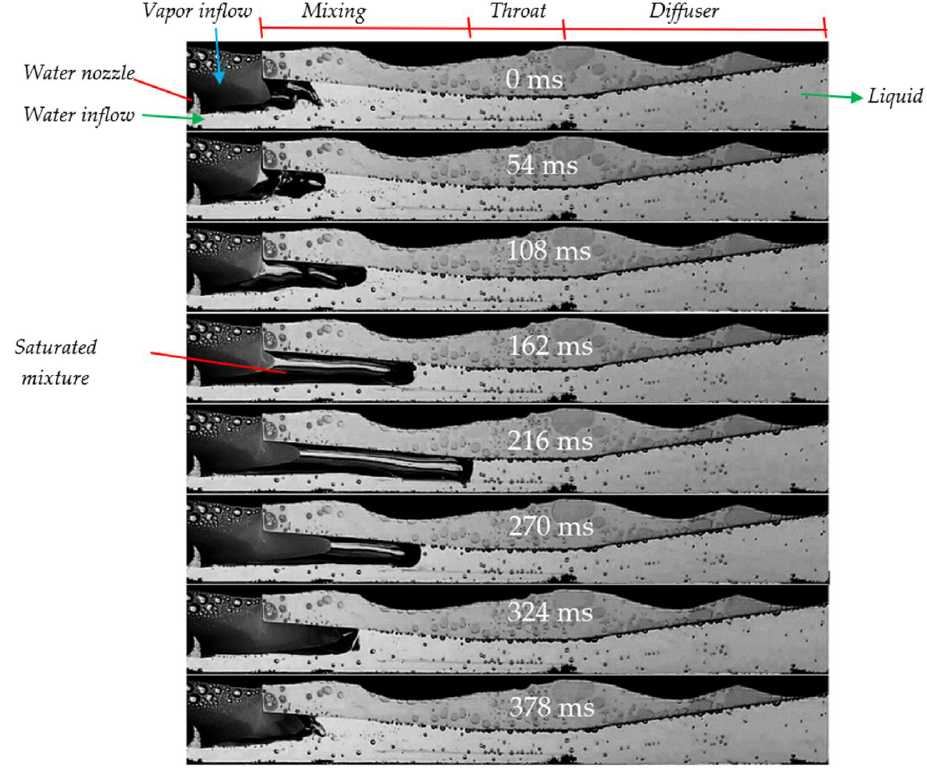
Figure 13. Framewise observation of phase change within Eductor